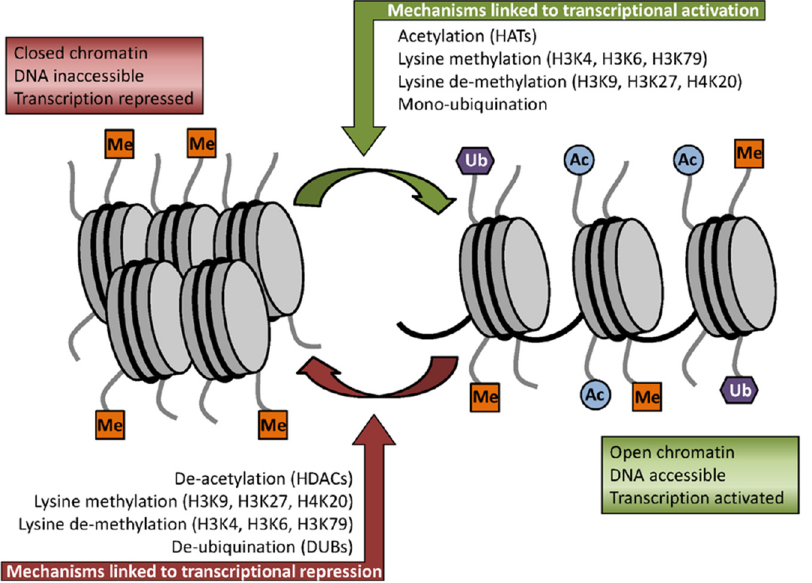
Figure 4. Some of the key histone modifications influencing gene expression (Me: methylation, Ub: ubiquination, Ac: acetylation). Reproduced from the original source [35] under the terms of Creative Common Attribution